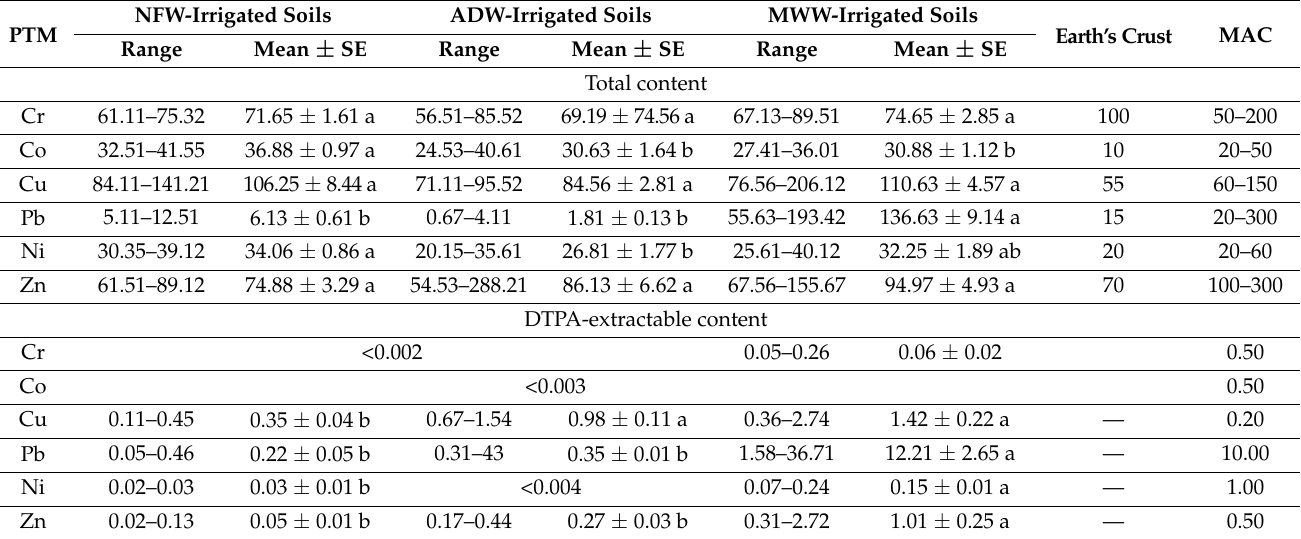
Table 3. Concentrations of PTMs in soils (mg kg − 1